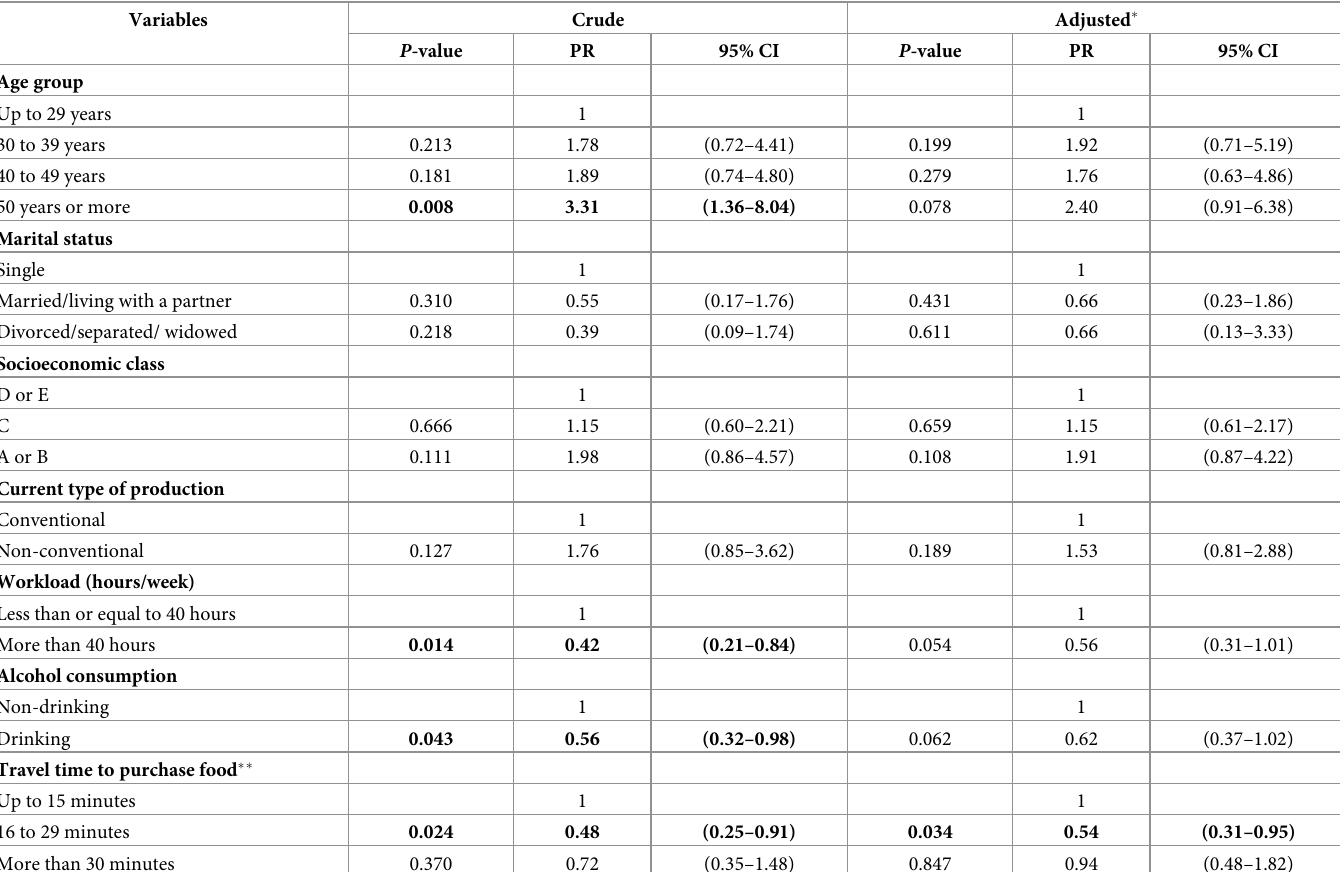
Table 6. Factors associated with abdominal obesity among men in a rural Brazilian